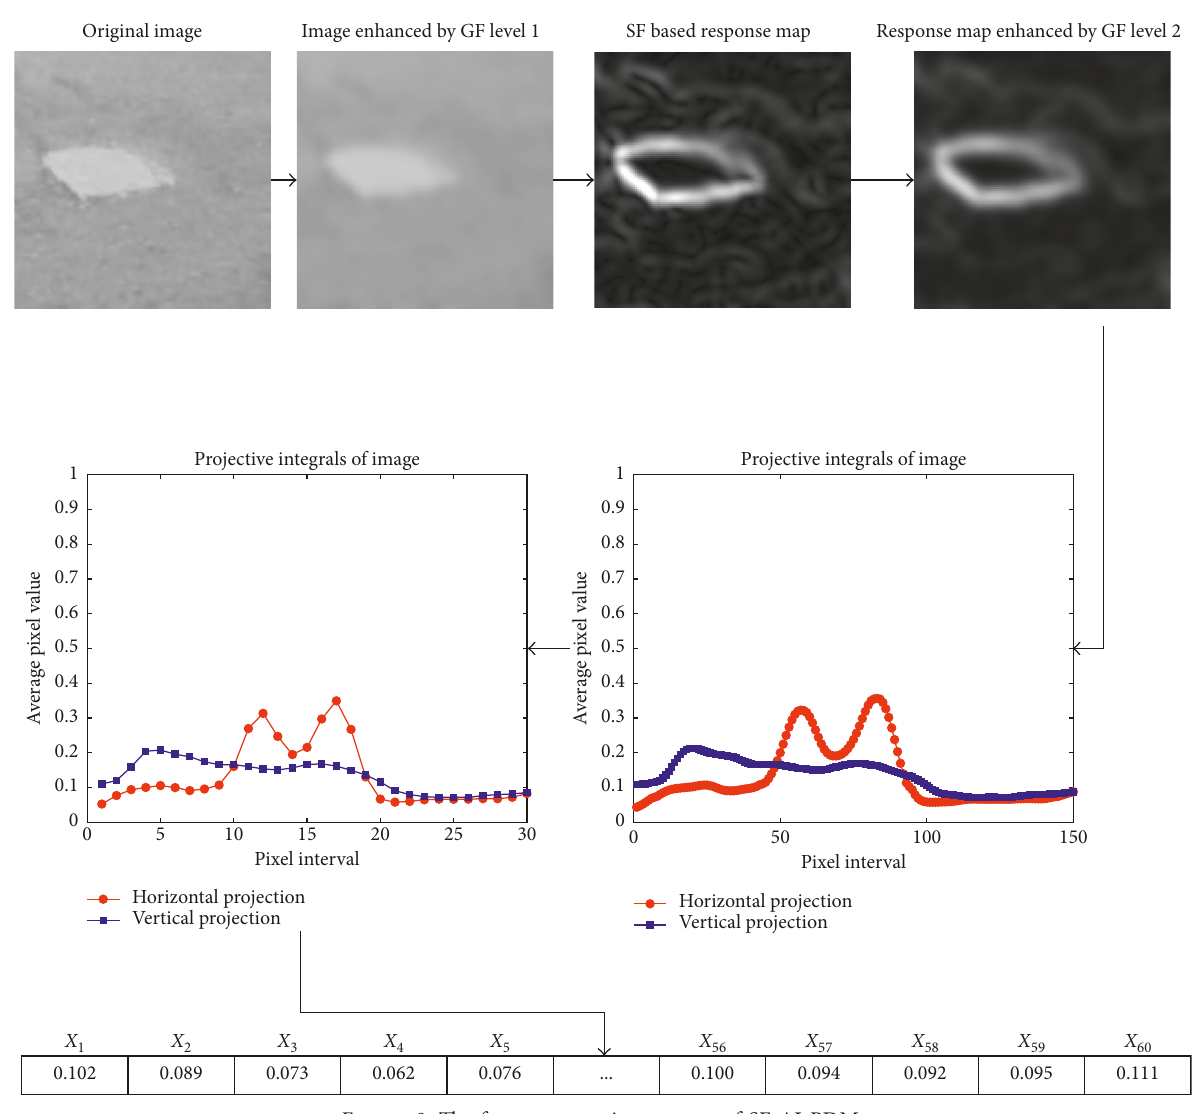
Figure 8: The feature extraction process of